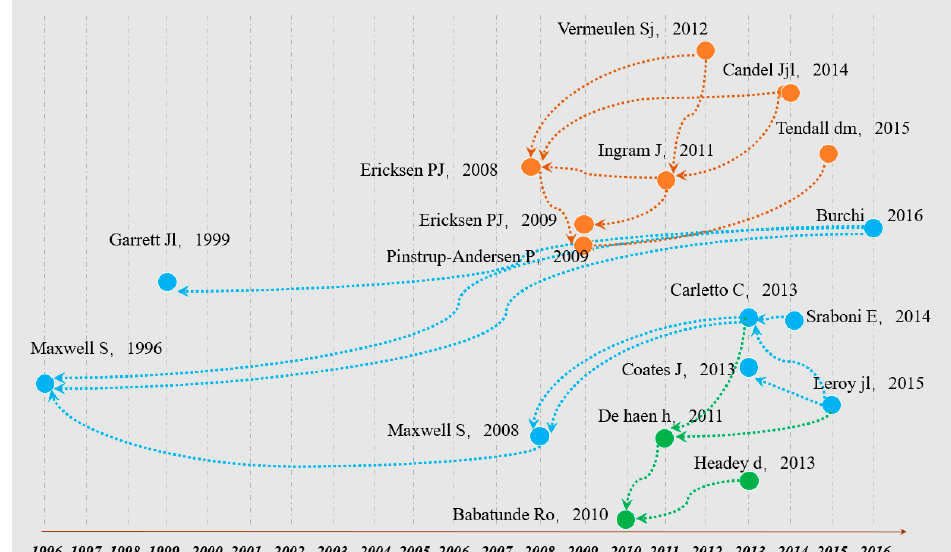
Figure 3. Historical direct citation network of papers published from 1996 to 2021 in the field of food security.